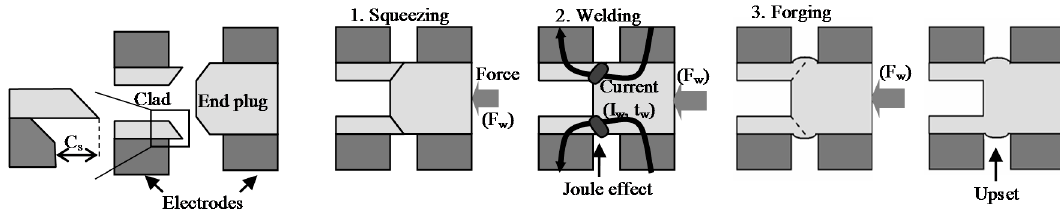
Figure 2. Schematic scenario of the resistance upset welding steps.